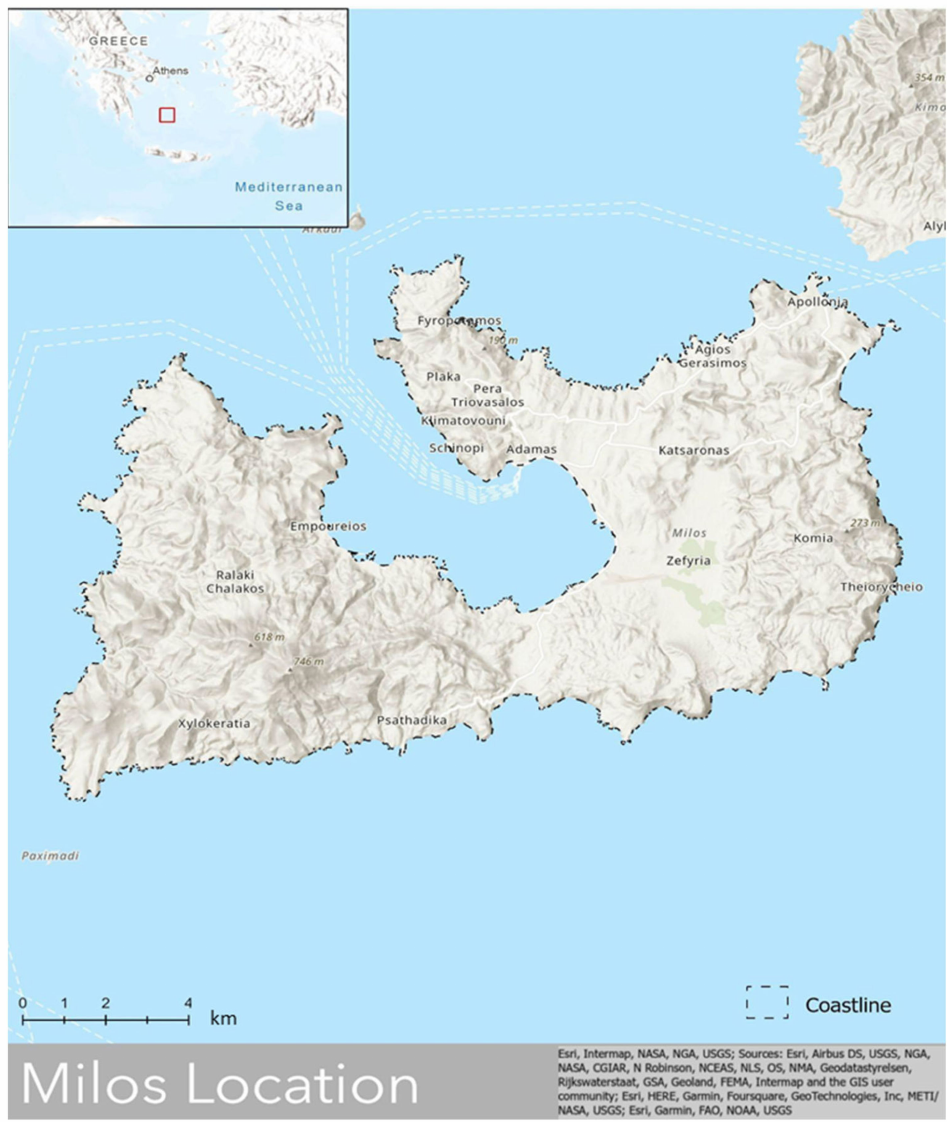
Figure 2. Topographic map of Milos Island. Inset map: Location of Milos in relation to the Hellenic region (ESRI